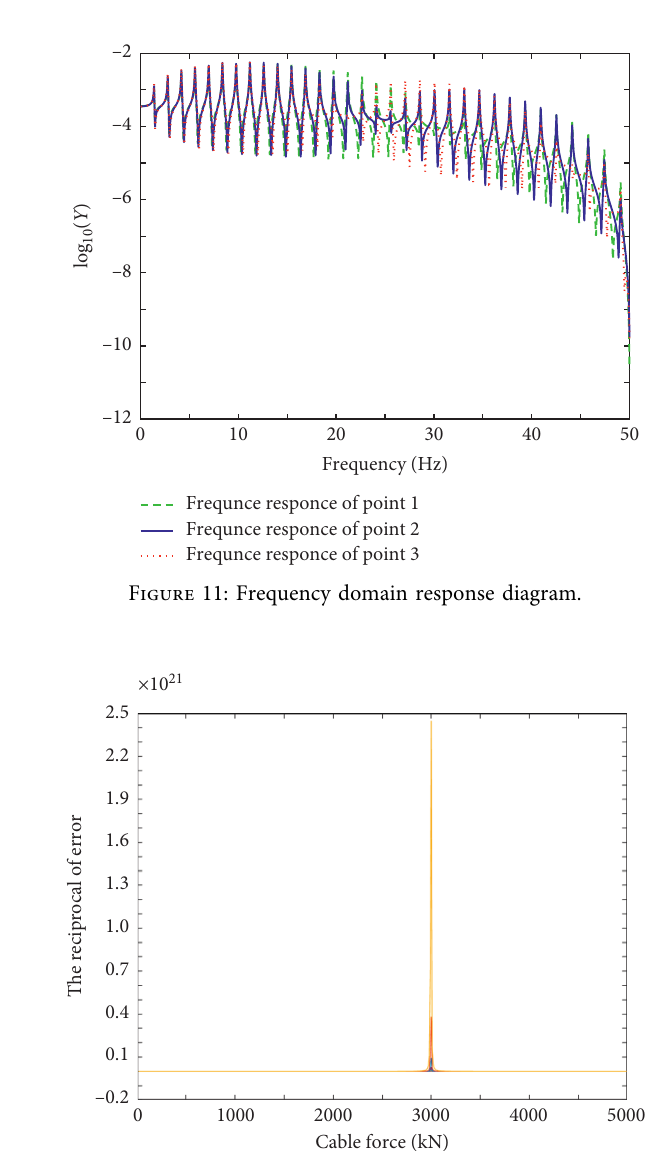
Figure 12: Schematic diagram of the cable force